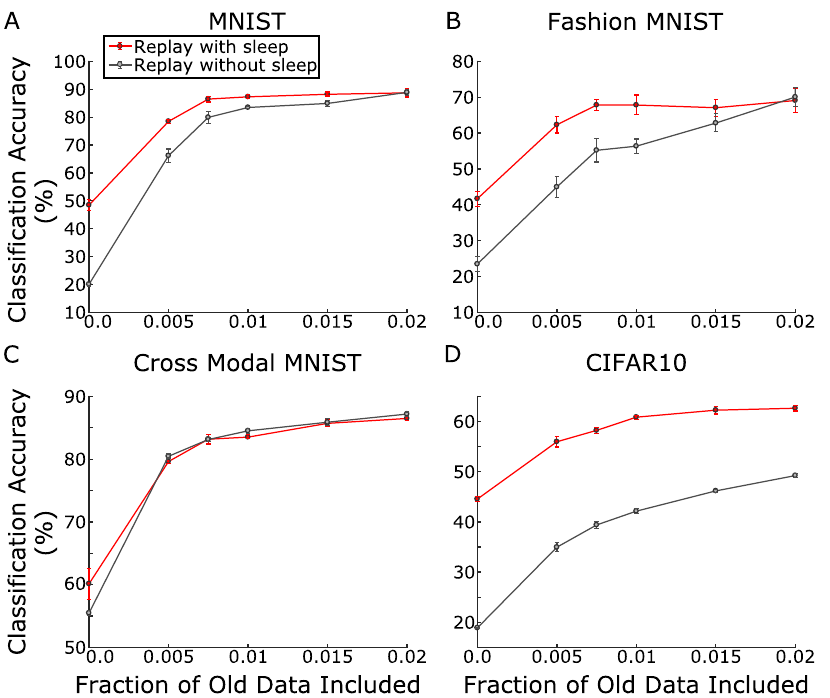
Fig. 3 | SRC is complementary to rehearsal - replay methods which store/gen- erate old examples and combine new data with these examples during train- ing. The classi fi cation accuracy as a function of percent of old data included is